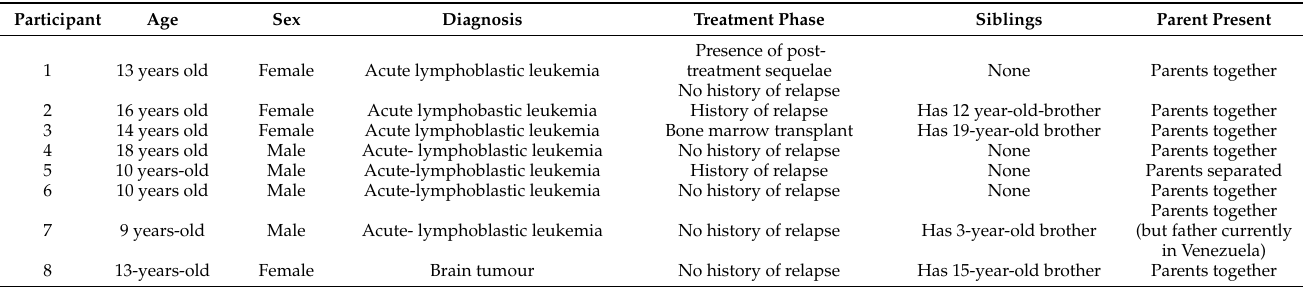
Table 1. Characteristics of the